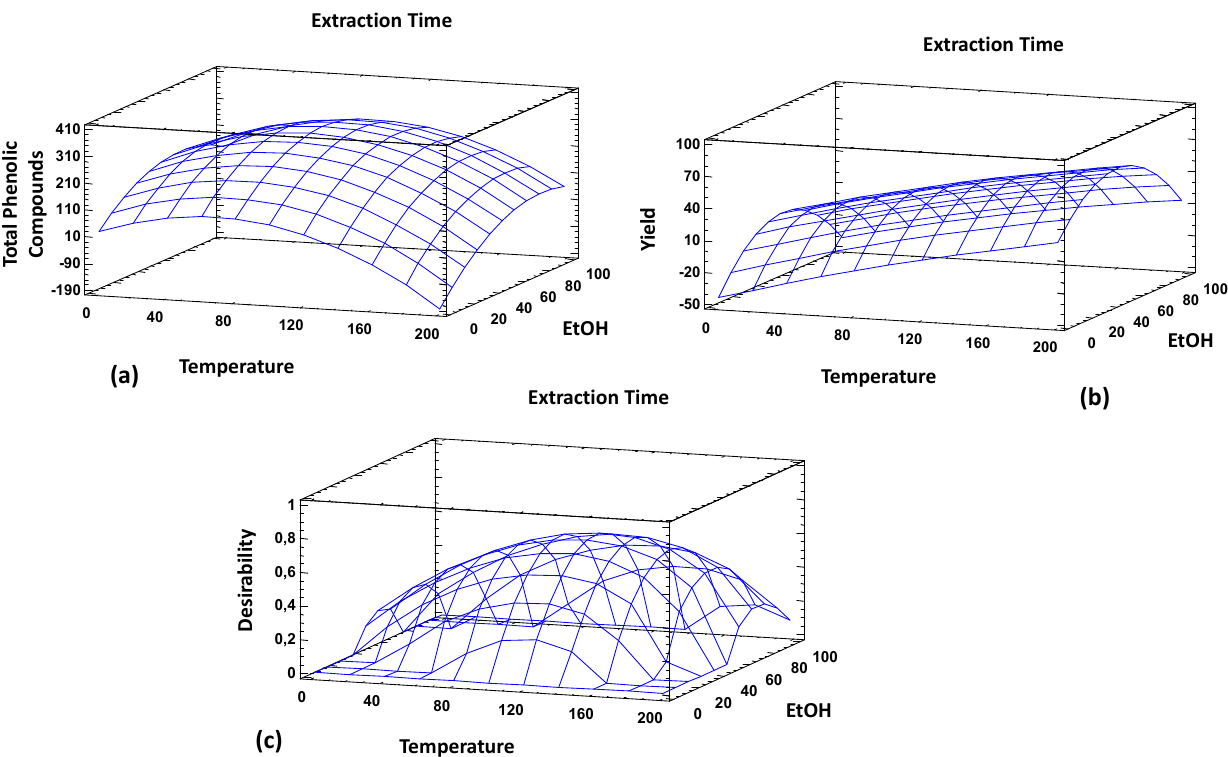
Figure 2. Surface response graphs: ( a ) phenolic compounds; ( b ) extraction yield; and ( c ) optimization of multiple responses.